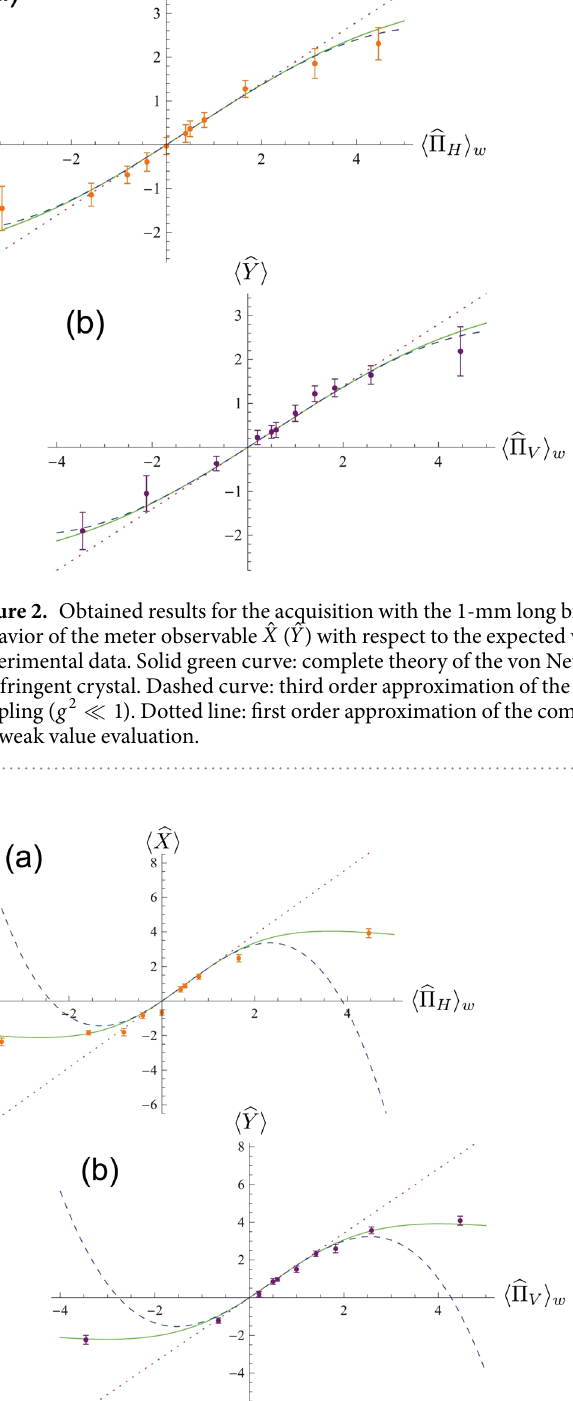
( 〈Π 〉 ˆ ). Dots: H w V w